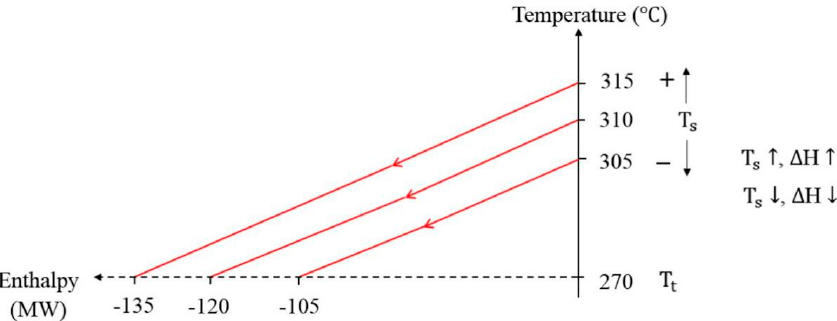
Figure 3. Effect of increasing or decreasing supply temperature (T S ) on a hot stream.